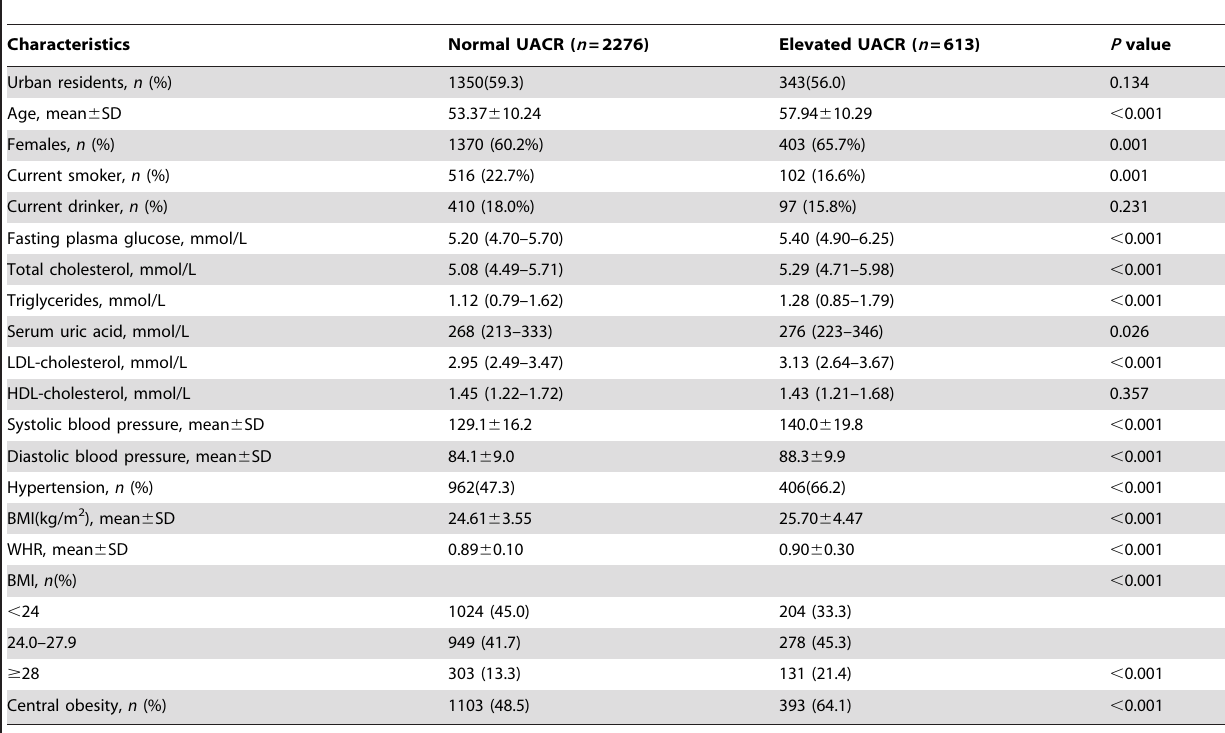
Table 1. Baseline characteristics of participants with normal and elevated urinary albumin-to-creatinine ratio.